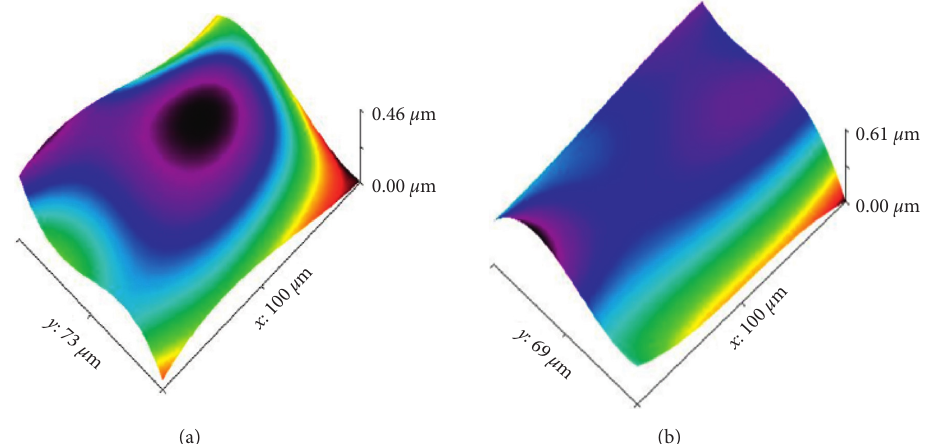
Figure 3: Structural analysis of (a) leached palm ash (b) synthesized zeolite Y.